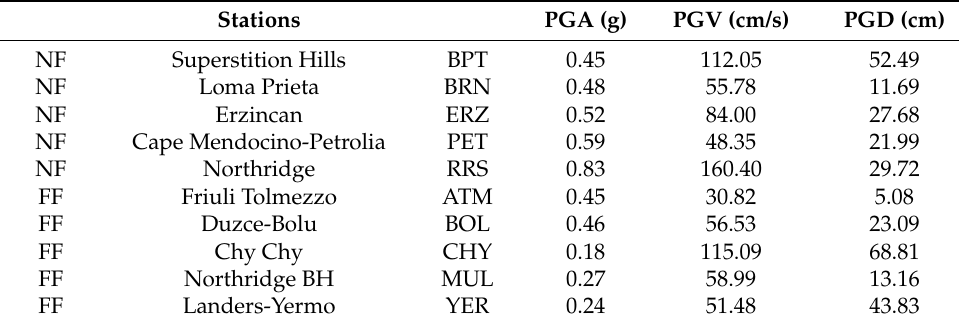
Table 8. Input motions